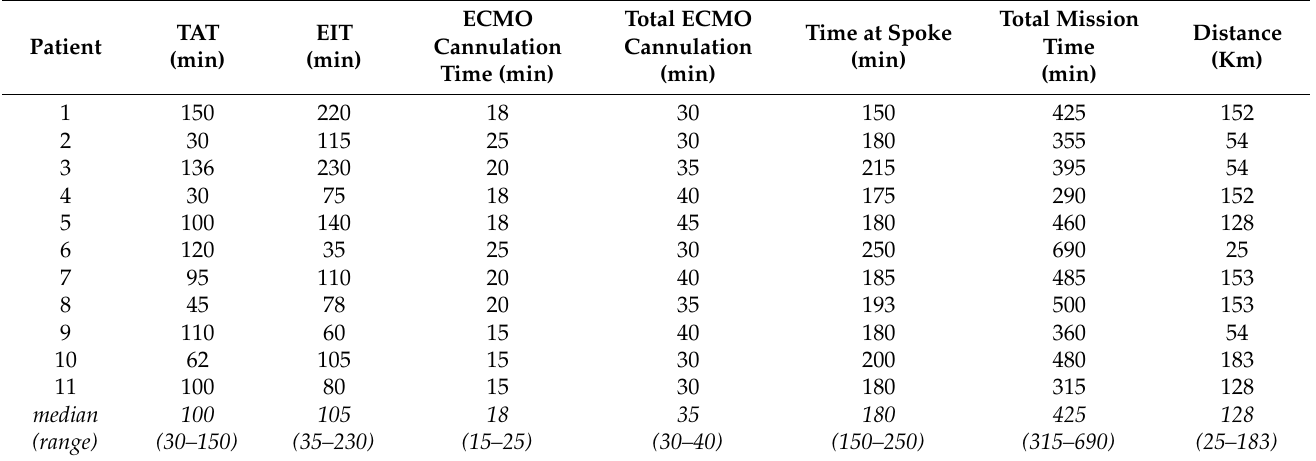
Table 4. Times of HandS ECMO